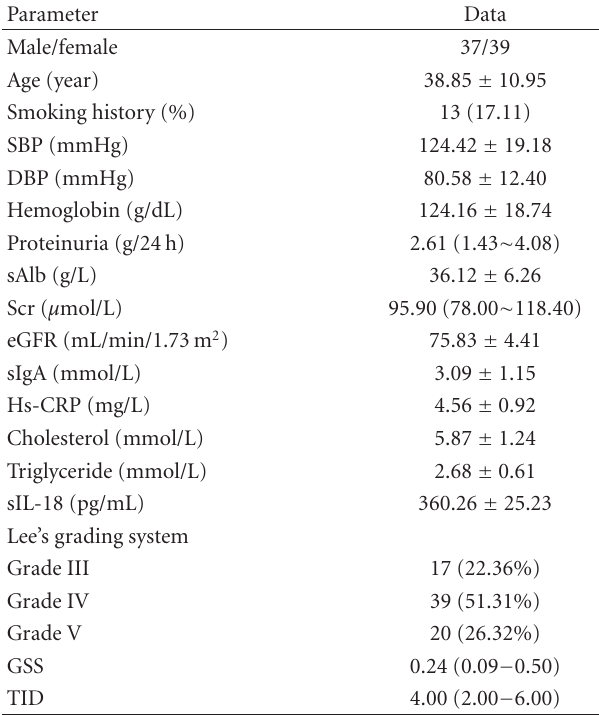
Table 1: Demographic, clinical, and histological data in IgAN pa- tients at baseline.